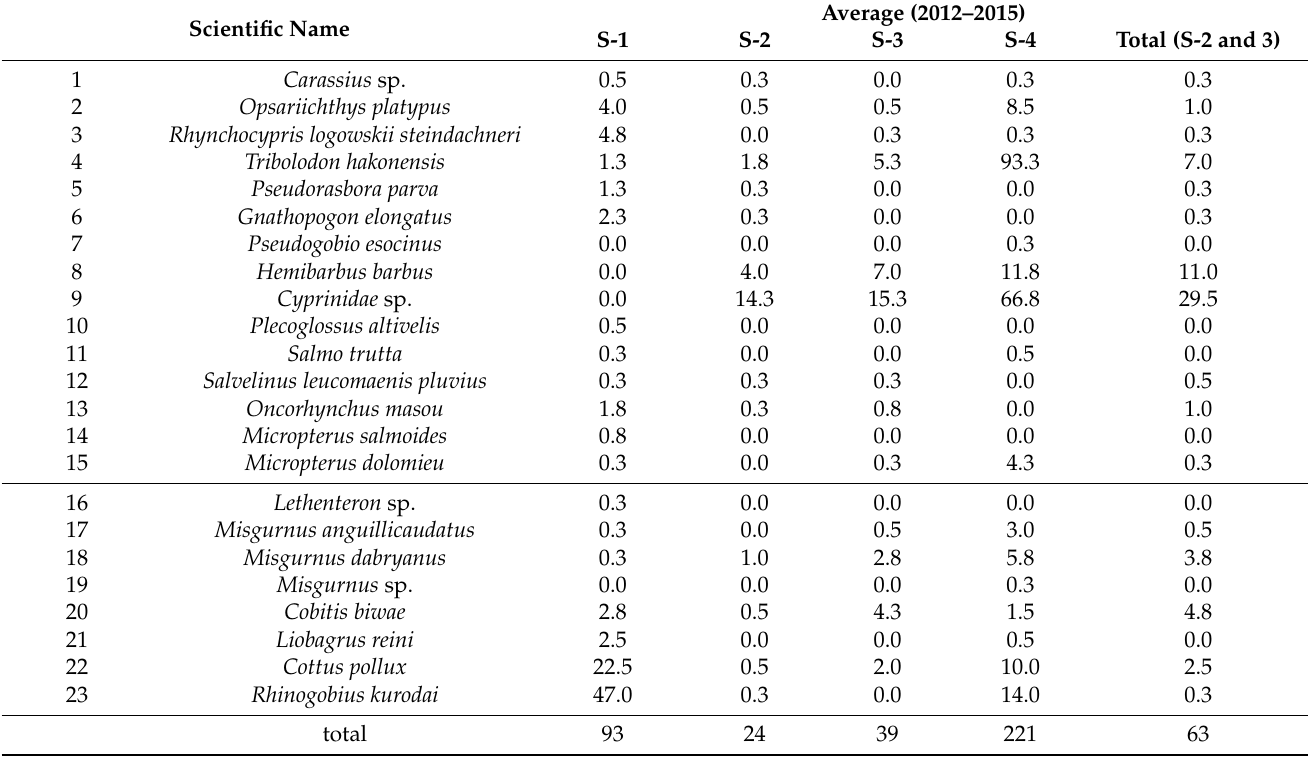
Table 6. Average numbers of catches at the midpoints of the rock-ramp fishway from 2012 to 2015. Fish 1–15 are not bottom-dwelling fish. Column S-1 presents the results from the upstream end, and the data overlap with the results in Table 4. Columns S-2 and S-3 depict the results from the midpoints of the rock-ramp fishway. Column S-4 lists the results from a point near the downstream submerged part at the entrance of the fishway and includes fish that did not run up the rock-ramp